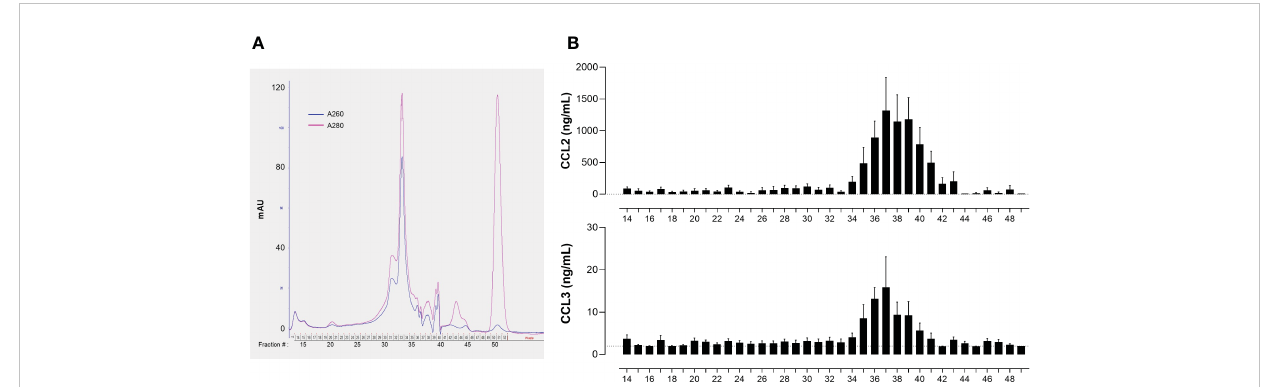
FIGURE 4 Bioactivity of T. cruzi trypomastigote OGE fractions obtained by size exclusion chromatography. (A) Typical chromatogram of a T. cruzi trypomastigote OGE separated on Superdex 75 GL. (B) CCL2 and CCL3 produced by ten-fold diluted whole cord blood cells cultured during 24h in response to each OGE fraction collected by size exclusion chromatography. CCL2 and CCL3 levels were determined in supernatants by ELISA (detection threshold 2 pg/mL, dotted line). Results are expressed as mean ± SEM of 23 tests corresponding to 7 fractionated OGE batches, each batch of fractions being tested on 3 to 4 different cord blood